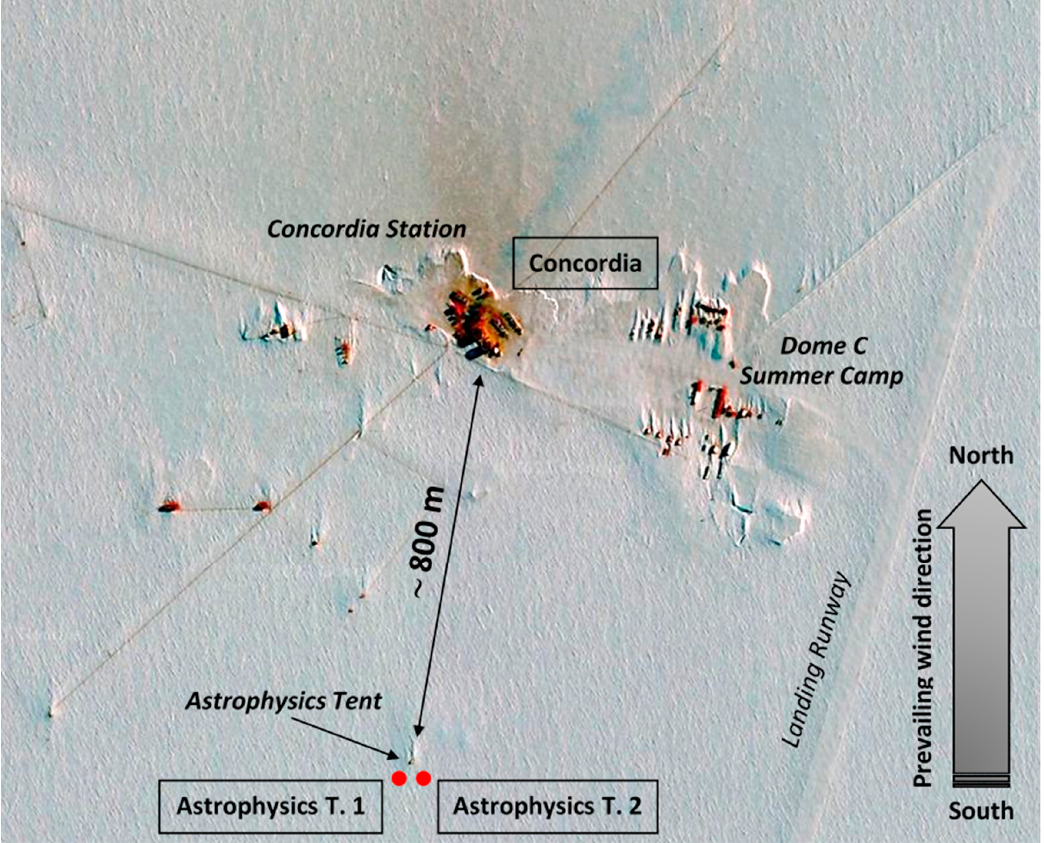
Figure 8. Satellite image of the Dome C area showing, among other things, the sampling points, the typical drift patterns of windblown snow around buildings and the pollution influence of the Concordia Station (from Google Earth).